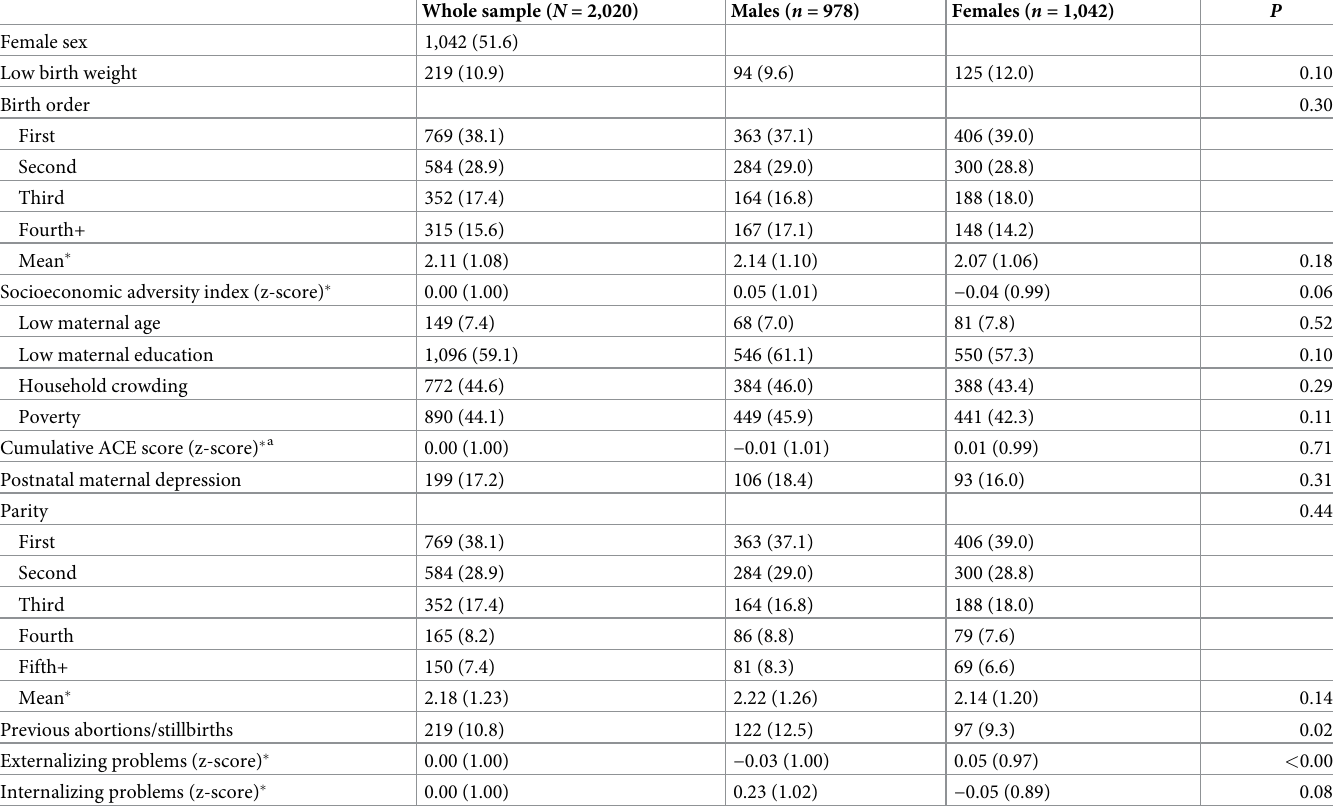
Table 1. Sociodemographic characteristics of the